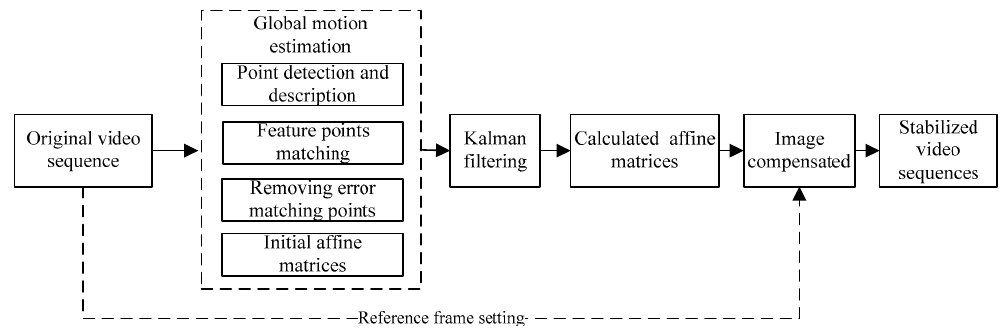
Figure 1. Block graph of the stabilization process.